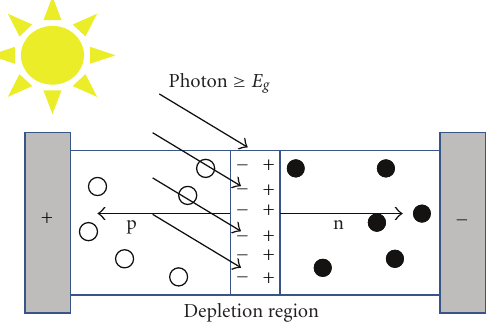
Figure 5: Basic p-n junction solar cell and charge transport phenomena.